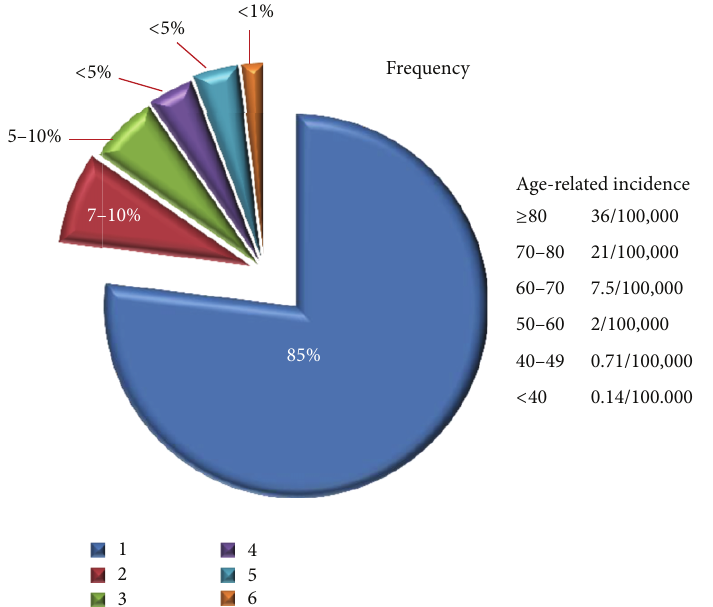
Figure 1: Age-related incidence of MDS and frequency estimates of MDS subsets. (1) De novo MDS (primary): estimates are 85% of all MDS. About45–50%manifestcytogeneticabnormalitiesevidentbystandardanalysiswithrecurringexamplesbeingdel(5q),del(7q),del(20q),and trisomy 8. (2) Secondary MDS: estimates are 7–12% of all MDS with > 80% relating to prior therapy with mutagenic chemicals and/or radiation (therapy-related, t-MDS). Chromosome aberrations are present in > 90%, particularly involving chromosomes 5 and 7, and often associated with complex cytogenetics and poor prognosis. (3) Cigarette smoking is strongly associated with MDS/AML and directly relates with the total amount smoked and current smoking at diagnosis. (4) Subsets of MDS characterized by ringed sideroblasts may have different causation from other MDS syndromes. (5) Perhaps 5–10% of individuals with MDS as defined only by morphologic aberrations and cytopenias and with clinical features suggesting autoimmune disease may respond favorably to immunosuppressive therapy. (6) Occupational/environmental chemical exposures are thought to cause < 1% of all MDS with benzene-related disease some fraction of this amount.